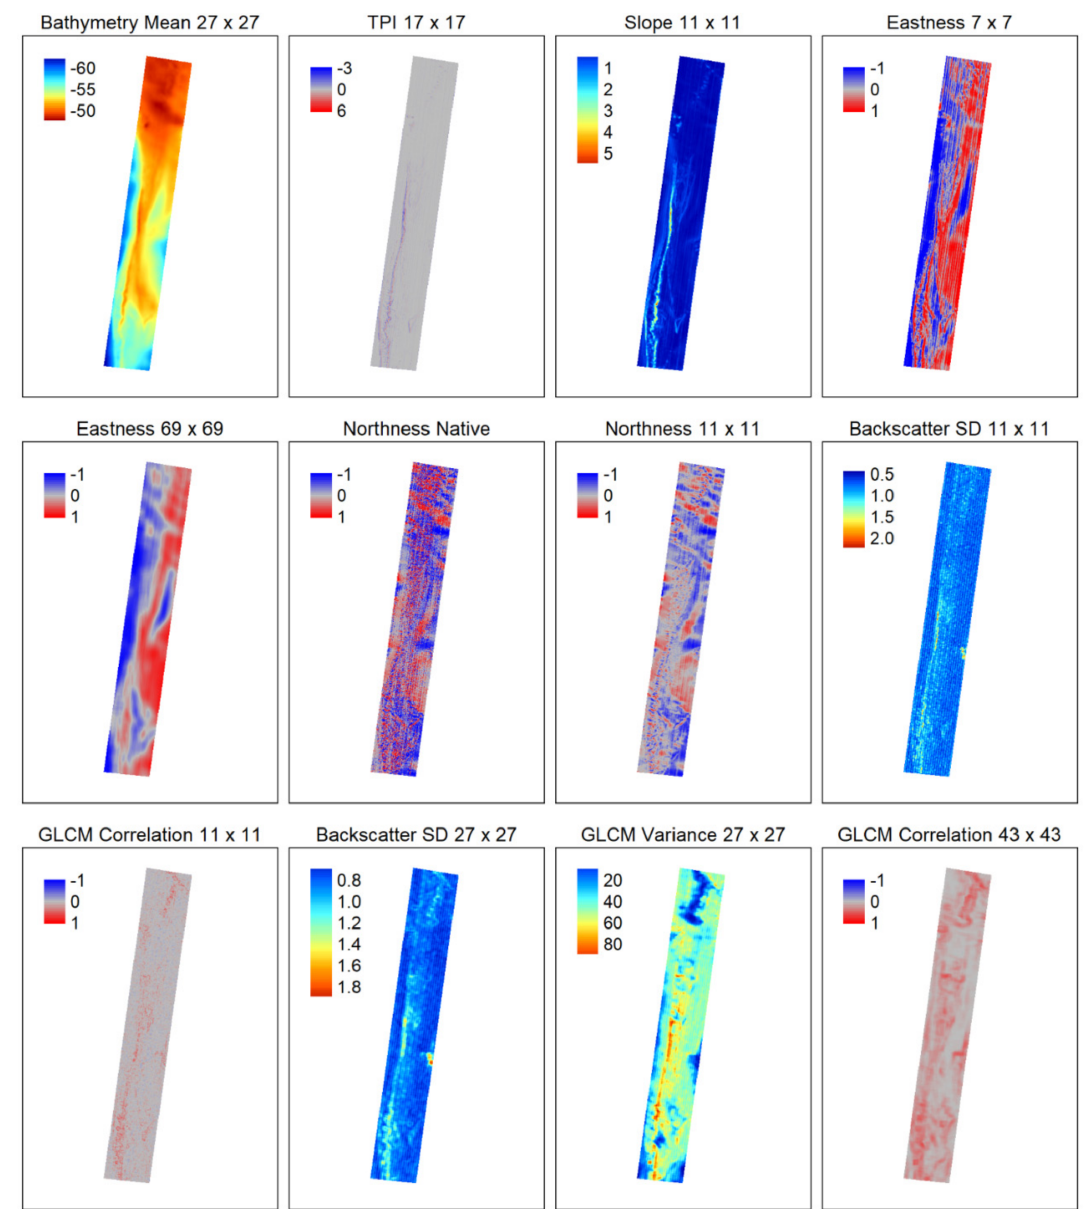
Figure 5. Retained predictor variables used in the random forest supervised classification model for